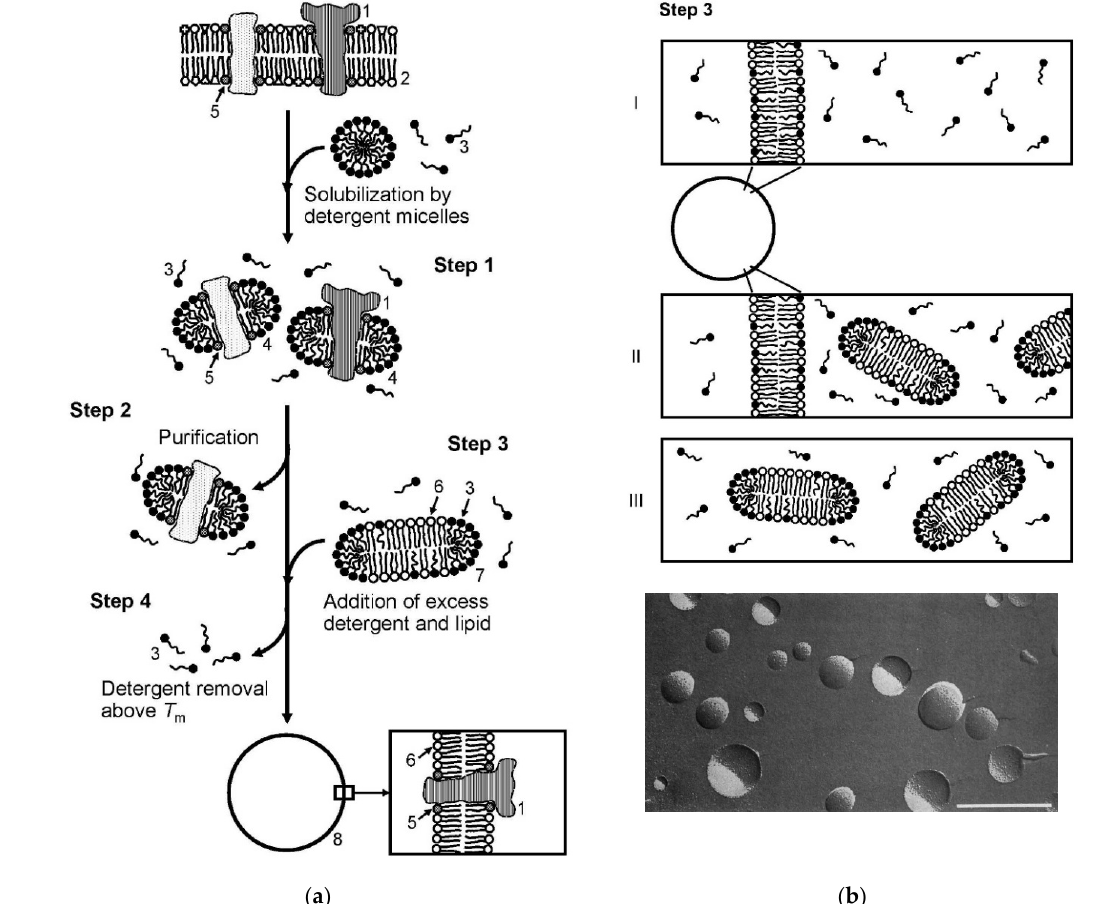
Figure 38. Membrane protein reconstitution in LUVs. ( a ) Schematic representation of the concept of one of the procedures that were developed for the preparation of LUVs containing a desired membrane-embedded protein (“proteoliposomes”) by using a micelle-forming amphiphile (detergent). The procedure consists of four main steps, as described by Rigaud and collaborators [517,521]. Step 1 : The membrane protein (1), which originally was present in a biological membrane (2), is first solubilized with detergent molecules (3) as mixed micelles (4). The mixed micelles contain some of the biomembrane lipids (5), and the mixed micelles are in dynamic equilibrium with non-associated detergent molecules. After purification ( step 2 ), excess bilayer-forming lipids (6) and detergents (3) are first added ( step 3 , the case of added mixed lipid-detergent micelles is shown (7); see ( b ) for other possibilities). Step 4: The detergent molecules are then removed (by polystyrene bead adsorption, dialysis, size exclusion chromatography or dilution) to yield lipid vesicles with the desired membrane protein embedded within the vesicle bilayer (8). ( b ) Top : The three possibilities for adding excess detergent and lipid to a solubilized and purified membrane protein; see step 3 in ( a ). I : Mixed lipid-detergent vesicles that are saturated with detergent molecules, existing in equilibrium with non-associated detergent molecules. II : Mixed lipid-detergent vesicles that are saturated with detergent molecules, coexisting with mixed detergent-lipid micelles, existing in equilibrium with non-associated detergent molecules. III : Mixed detergent-lipid micelles, existing in equilibrium with non-associated detergent molecules. Please note that in all these cases, the concentration of non-associated lipid molecules is assumed to be negligibly small. This assumption holds for conventional bilayer-forming phospholipids like POPC, CVC (POPC) ~ 10 − 10 M [127,128] (see Section 2.15). The drawings are slightly modified versions of previously published figures, [518]. Bottom : Freeze-fracture electron microscopy image of LUVs containing membrane-embedded bacteriorhodopsin from Halobacterium halobium (bar: 500 nm); see [516]. The sample was prepared from a 9:1 molar mixture of egg PC and egg PA without any detergent, but instead by using the “reverse-phase evaporation method” (see Figure 17a), followed by polycarbonate membrane extrusion using membranes with average pore diameters of first 400 and then 200 nm, yielding LUVs with a relatively broad size distribution centered around 150 nm. High resolution images show that about 20 – 200 membrane-embedded proteins are present per LUV, depending on the protein to lipid ratio used; see [516]. Reproduced with small modifications from [191], American Scientific Publishers, 2004; and with permission from [516], Elsevier, 1987.